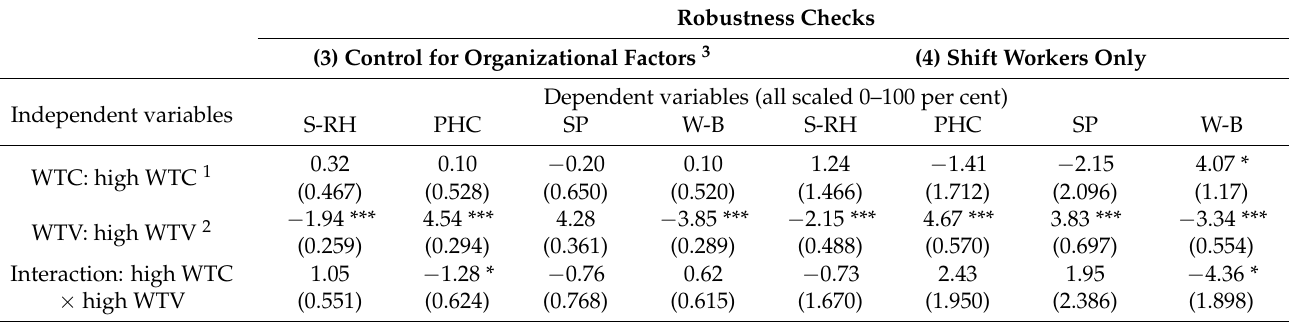
Table A3. Results of robustness checks, part II (organizational factors and shift work). Robustness